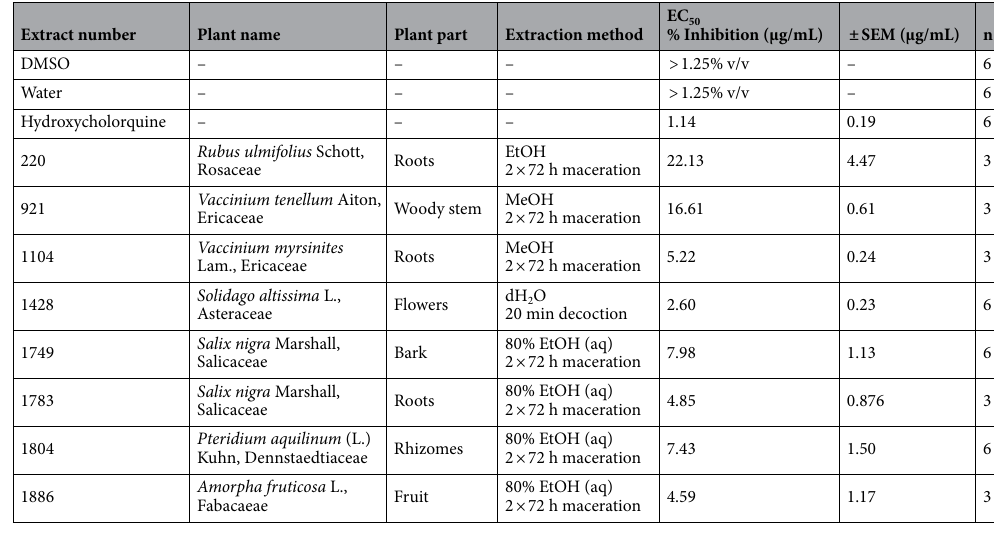
Table 1. EC 50 values were calculated by modeled dose–response curves against the wild type SARS-CoV-2 pseudovirion model using non-linear regression. This experiment was preliminary to help narrow in on potential leads for further characterization. SEM standard error mean.